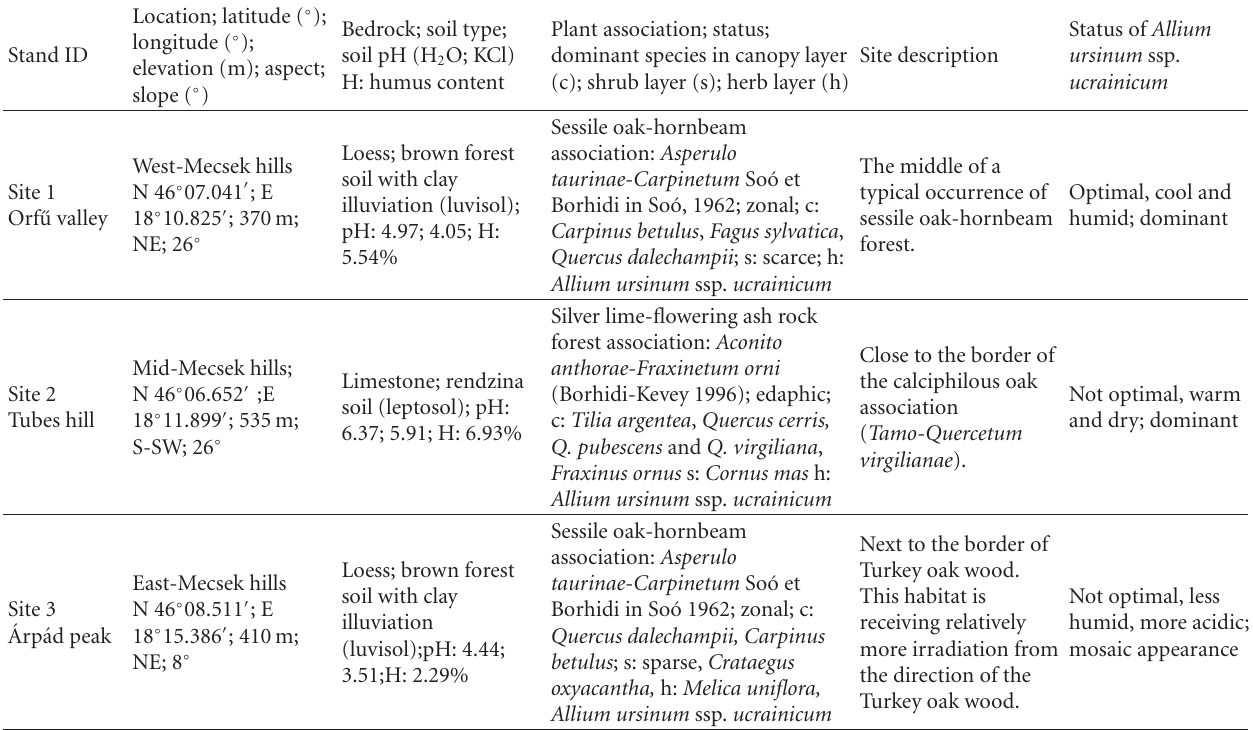
Table 1: Characteristics of the sampled forest stands.